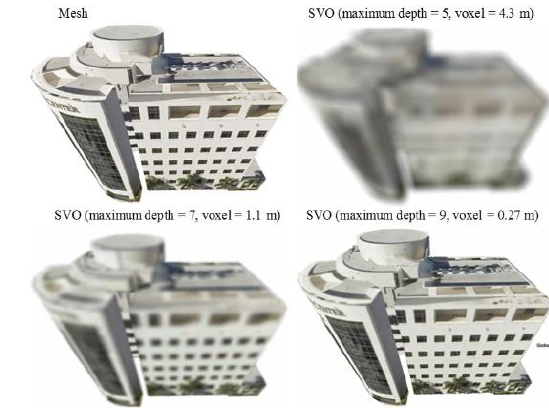
Figure 4. Voxel presentation at different scales (Liang and Gong,